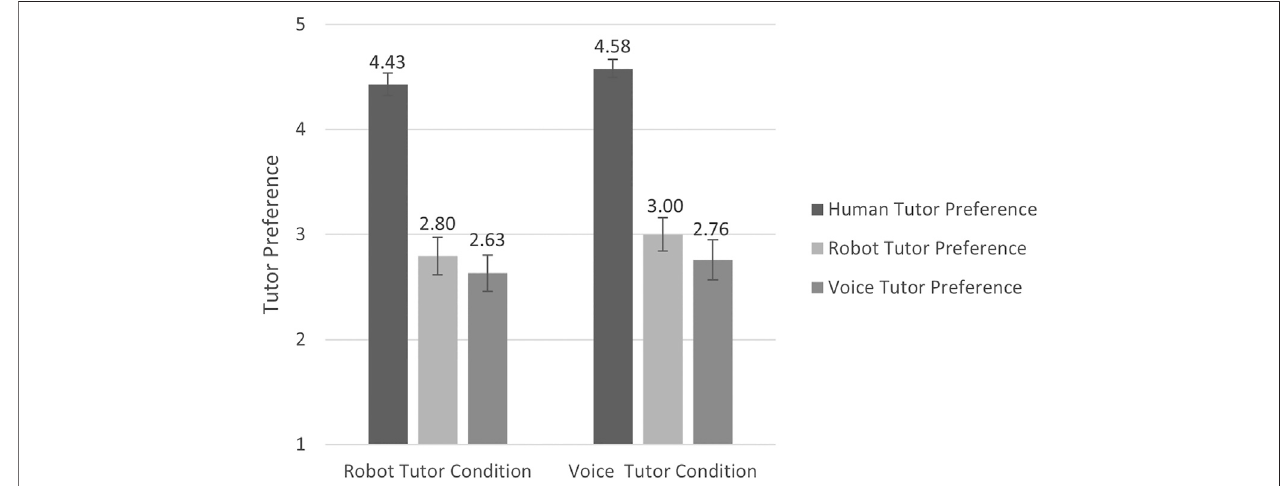
FIGURE 6 | Preference ratings for each tutor after the lesson. N (cid:1) 49 in the robot tutor condition; N (cid:1) 50 in the voice tutor condition. The highest possible score for each test was 5. The error bars indicate the standard errors.